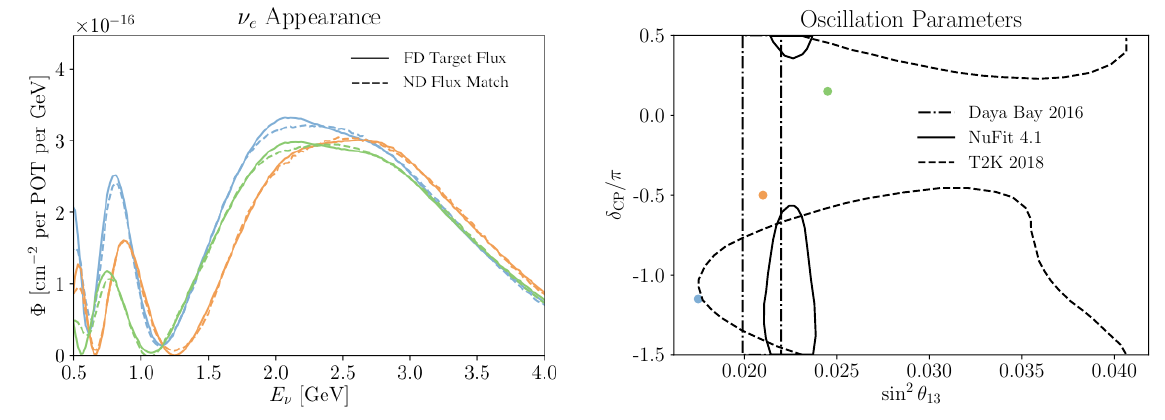
Figure 107. The flux matching of the ND ν µ flux to the oscillated FD ν e flux ( left ) is shown assuming various sets of oscillation parameters ( right ). Target fluxes are shown with solid lines and resulting fits are shown in dashed lines.